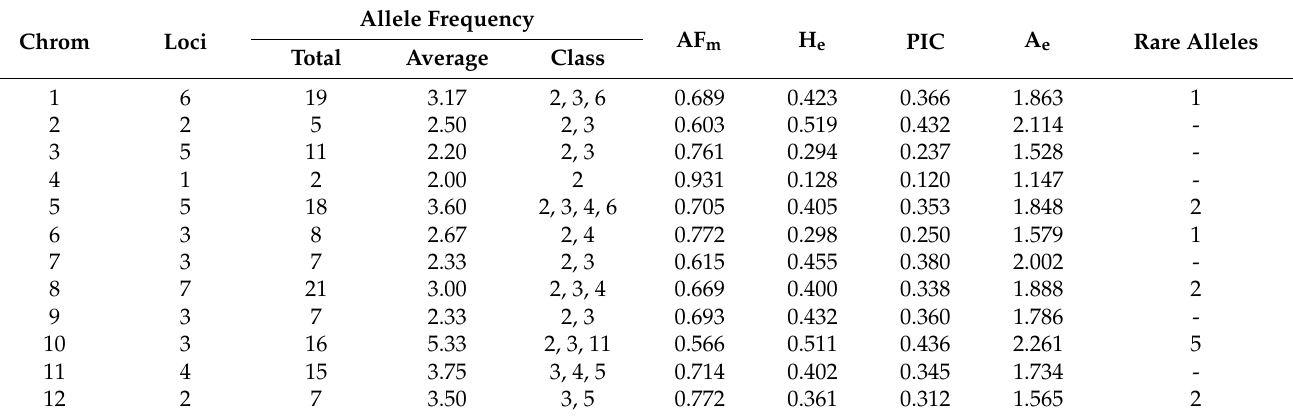
Table 4. Marker statistics based on 46 GCP panel microsatellite markers among the tropical japonica